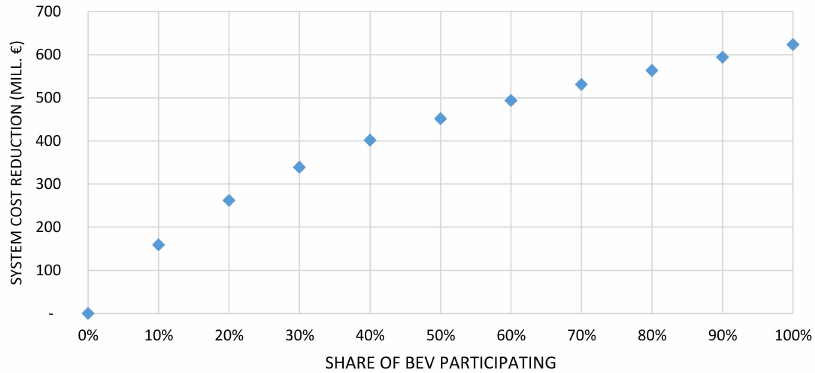
Figure 9. System cost reduction due to BEV-DSI in relation to the share of BEV participating in the